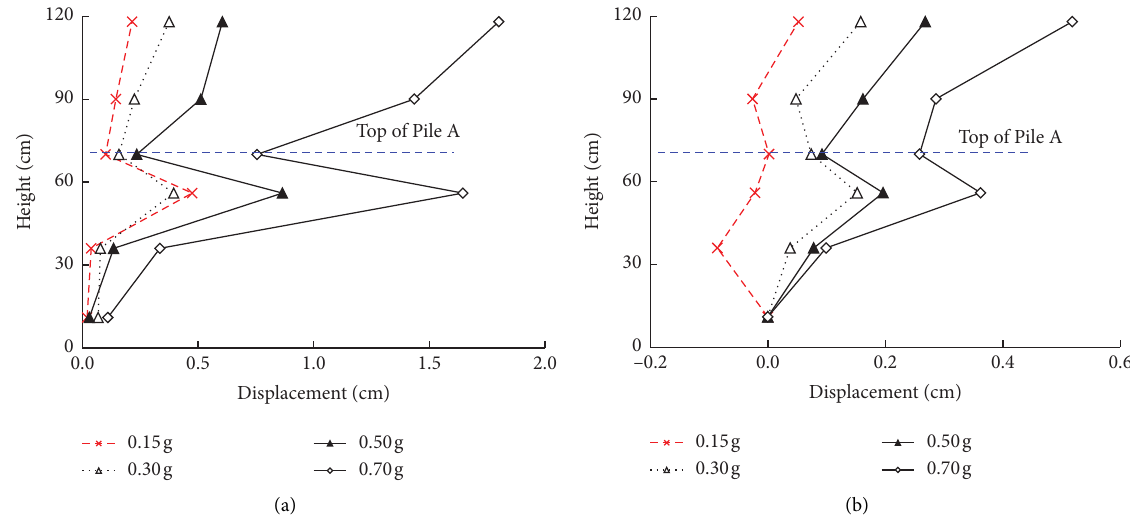
Figure 15: Horizontal displacements on the slope surface under the excitations of El Centro earthquake motion. (a) Peak displacement, (b) Permanent